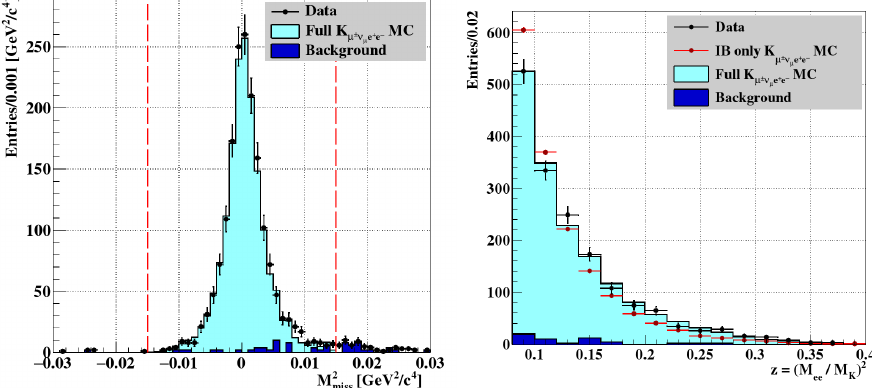
Figure 2. Left plot: missing mass squared distribution after the final selection. Vertical lines show the signal region. Right plot: z distribution after the final selection. The results of signal MC simulation for the full MC model and for the IB contribution only are scaled to the total number of experimental events after background